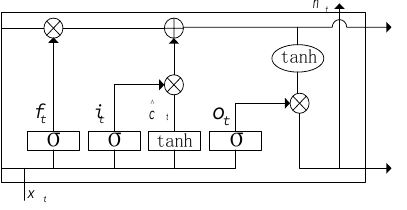
Fig. 1. LSTM cell structure